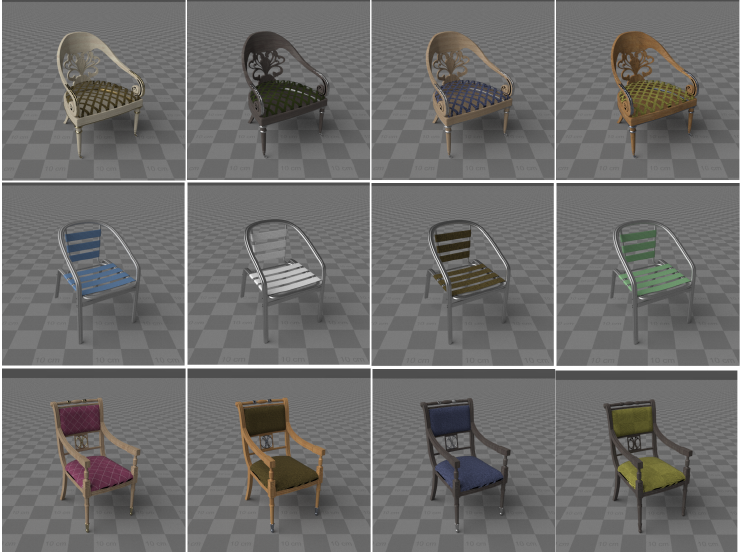
Figure 4. Examples of preview for randomization results of assigning random materials to the different 3D chair